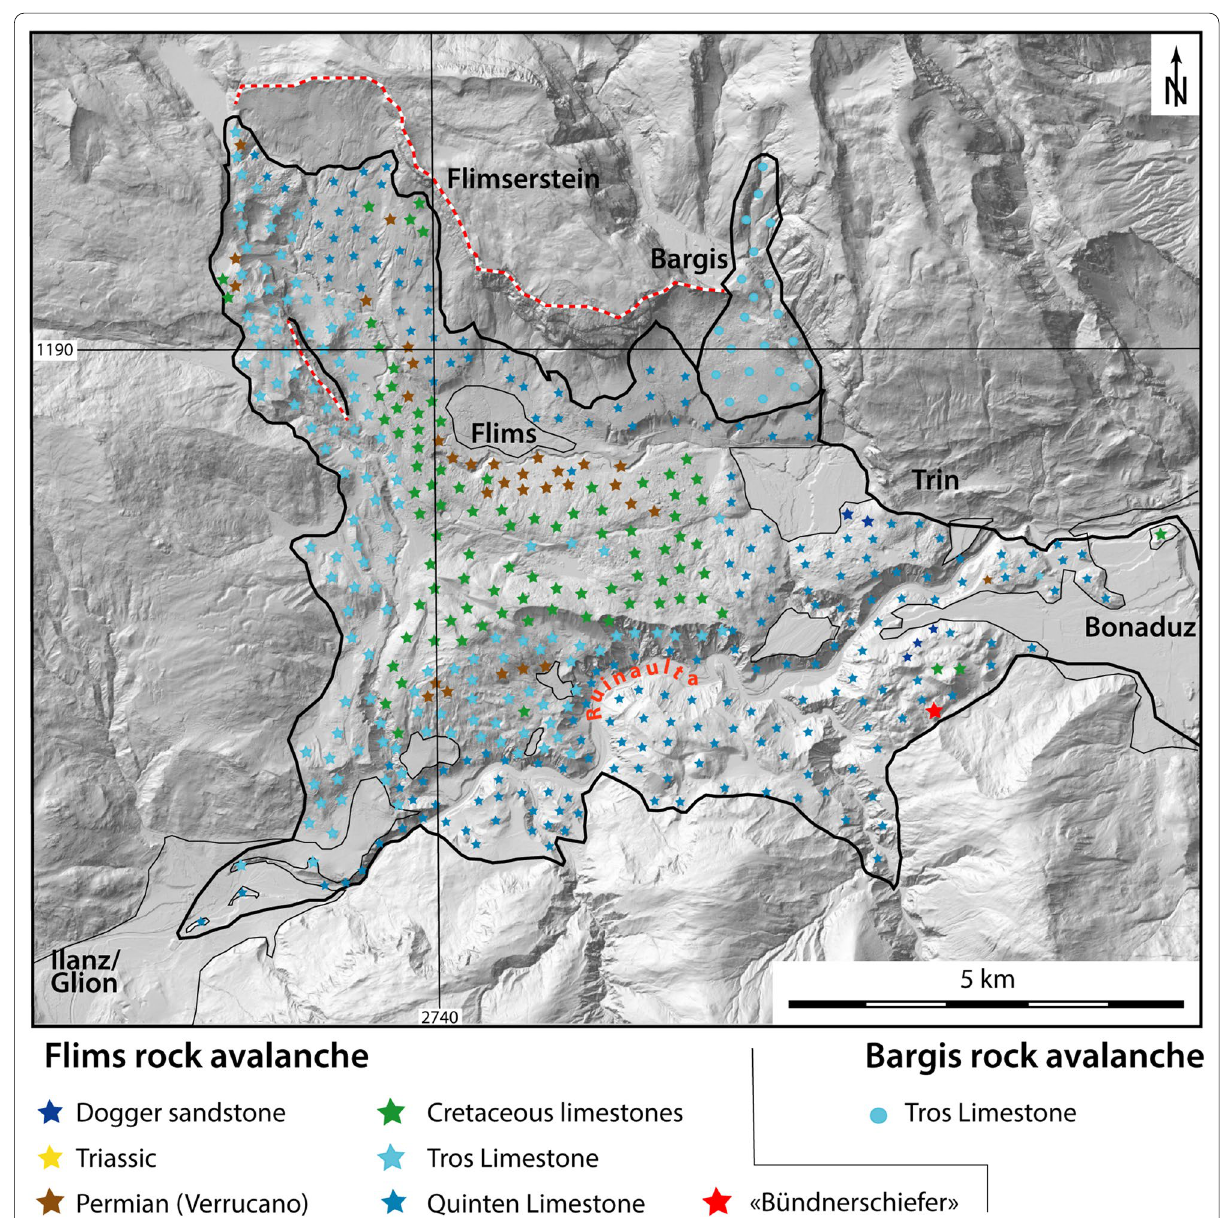
Fig. 5 Digital elevation model showing the distribution of lithologic units in the Flims rock avalanche deposit. See text for